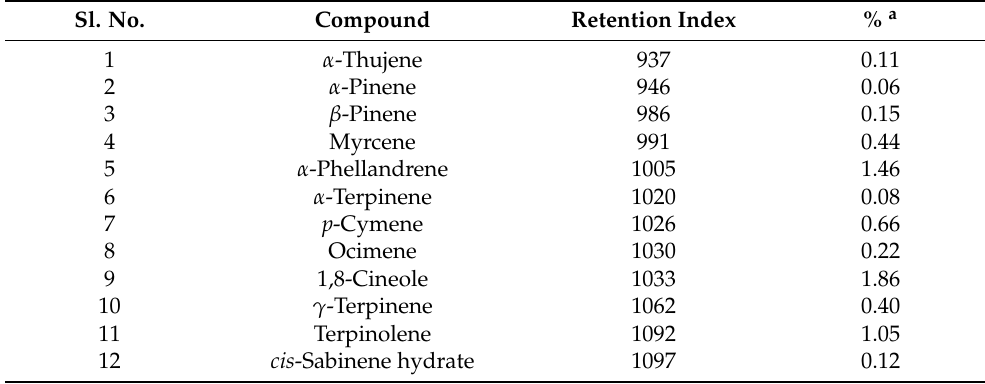
Table 1. GC-MS analysis of the essential oil extracted from Pimenta dioica leaves using steam distillation. Sl.